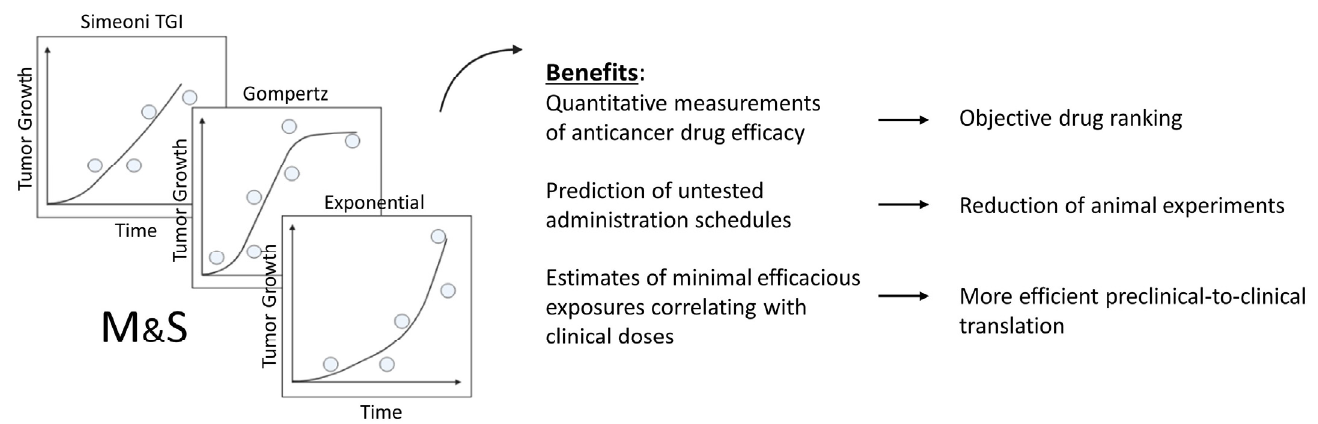
Figure 6. Model-informed preclinical development of anticancer agents.